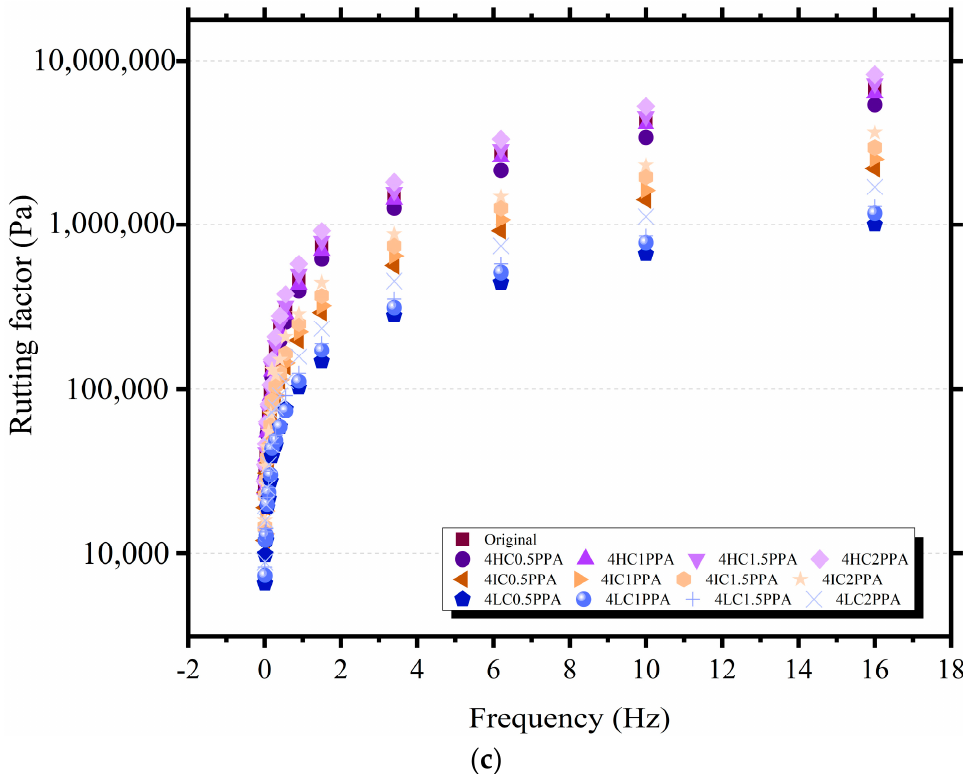
Figure 8. The frequency sweep results of modified bitumen. ( a ) Phase angle of modified bitumen. ( b ) Complex module of modified bitumen. ( c ) Rutting factor of modified bitumen.